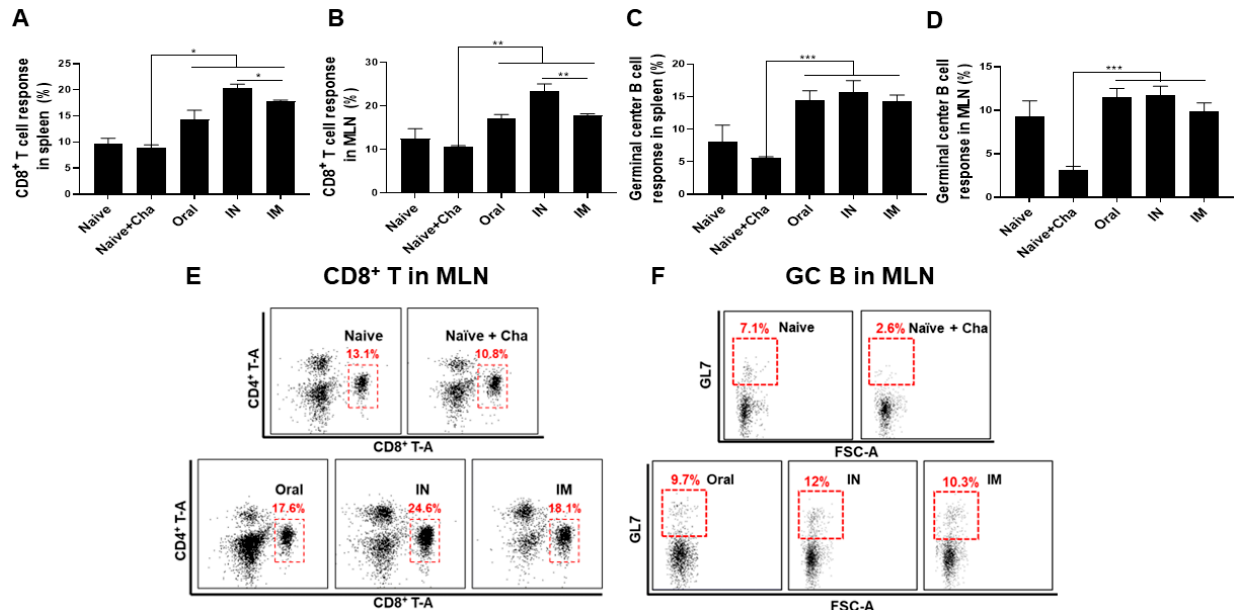
Figure 5. Mice were sacrificed at 35 dpi for sampling purposes. Flow cytometry was performed using the acquired splenocytes and MLN cells. CD8 + T cells from spleen ( A ) and MLN ( B ), as well as germinal center (GC) B cells from both spleen ( C ) and MLN ( D ) were detected after staining with appropriate fluorophore-conjugated antibodies. Scatterplots for CD8 + T cells and GC B cells from MLN were provided, with boxes indicating the gated CD8 + T cell population ( E ) and GC B cell population ( F ). Data are presented as mean ± SD and asterisks indicate statistical differences between groups. (* p < 0.1, ** p < 0.01, *** p < 0.001).